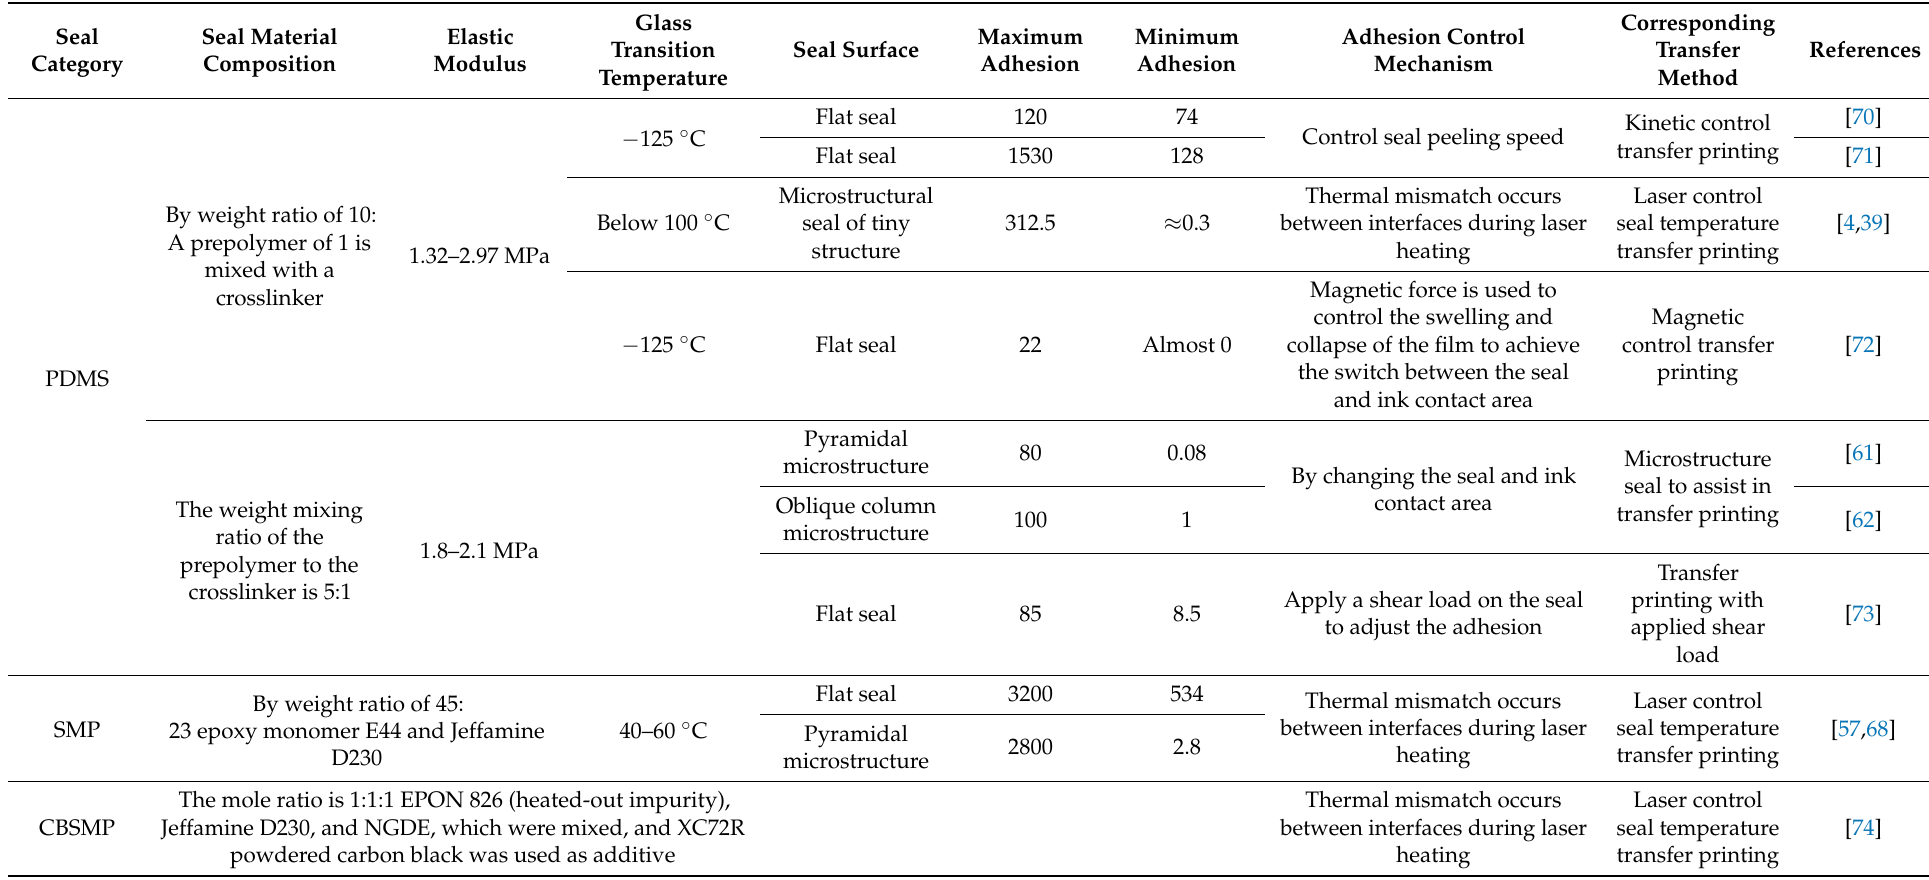
Table 1. Comparison of seal adhesion force with different